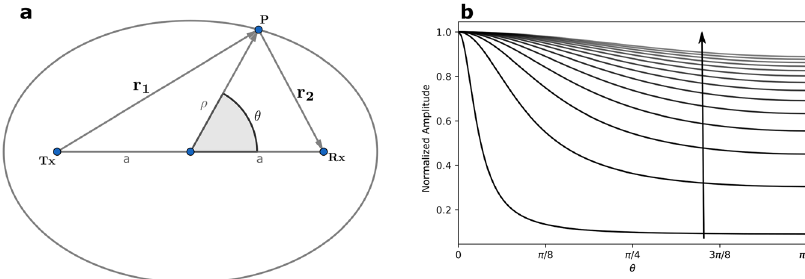
Fig. 1 Position evaluation based on time of fl ight. In panel a , a diagram showing an ellipse with focal points Tx and Rx as the solution to the equation r 1 + r = r and the corresponding polar coordinates ( ρ , θ ) description of a solution point P . In panel b , the amplitude of the fi eld at P as it travels the θ values 2 along the ellipse for increasing values of r de fi ned by the